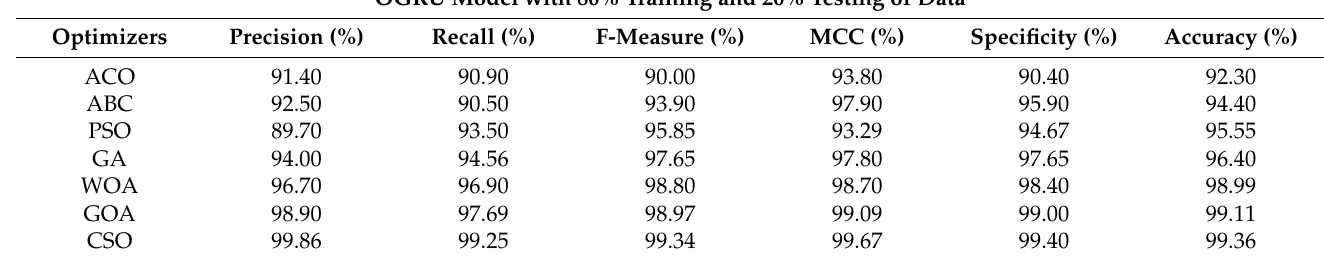
Table 4. Simulation results of the proposed model by varying the optimizers with 80:20% training and testing of data.